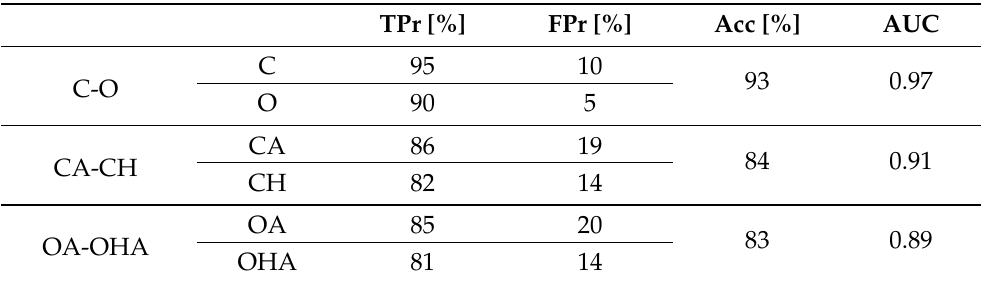
Table 7. Respiratory events classification performances for Fine Gaussian